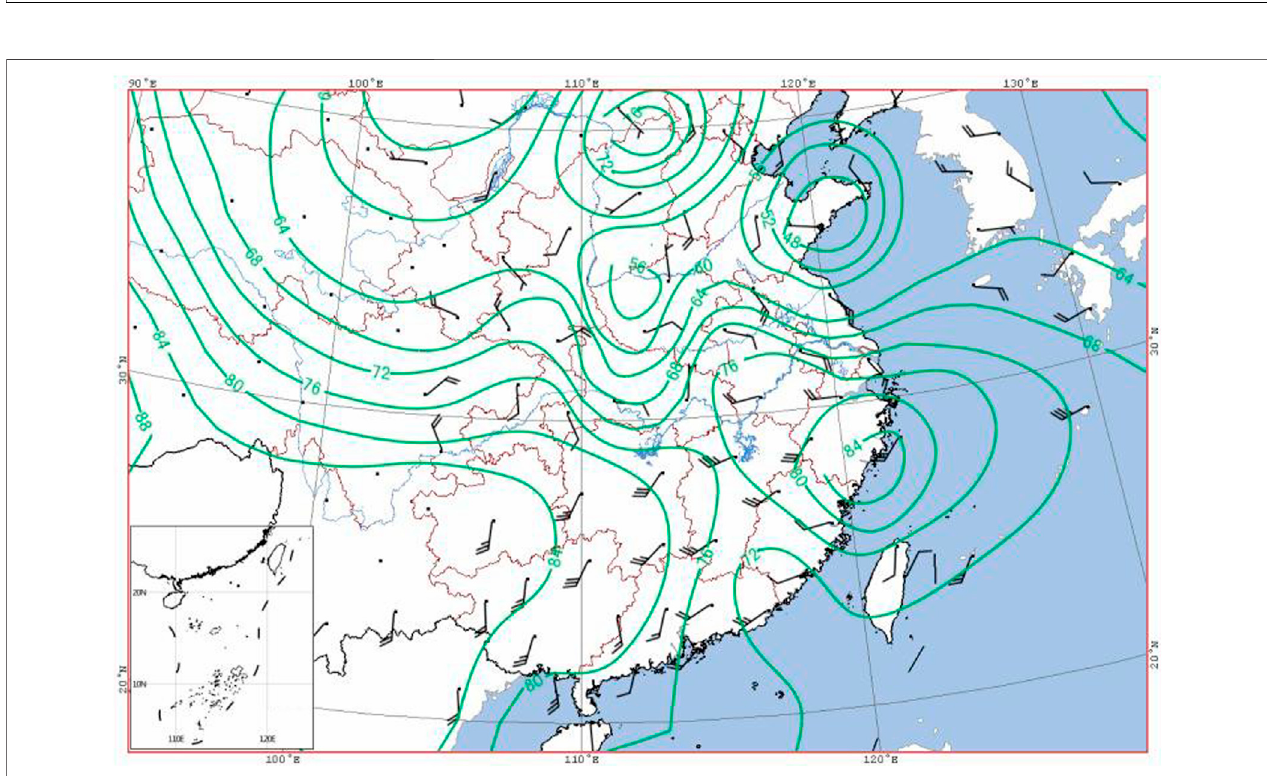
FIGURE 5 | Wind fi eld and pseudo equivalent temperature fi eld of 850 hPa at 20:00 on July 9, 2010 (green isolines).